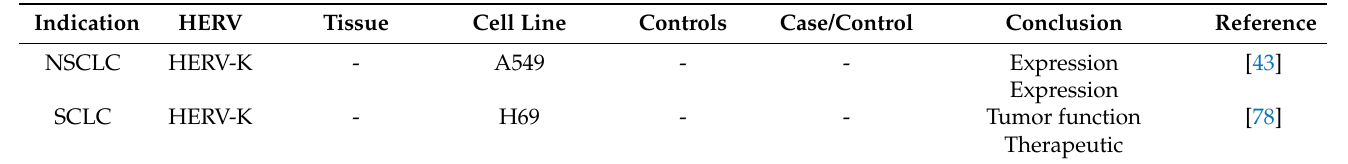
Table 10. HERV protein expression in lung